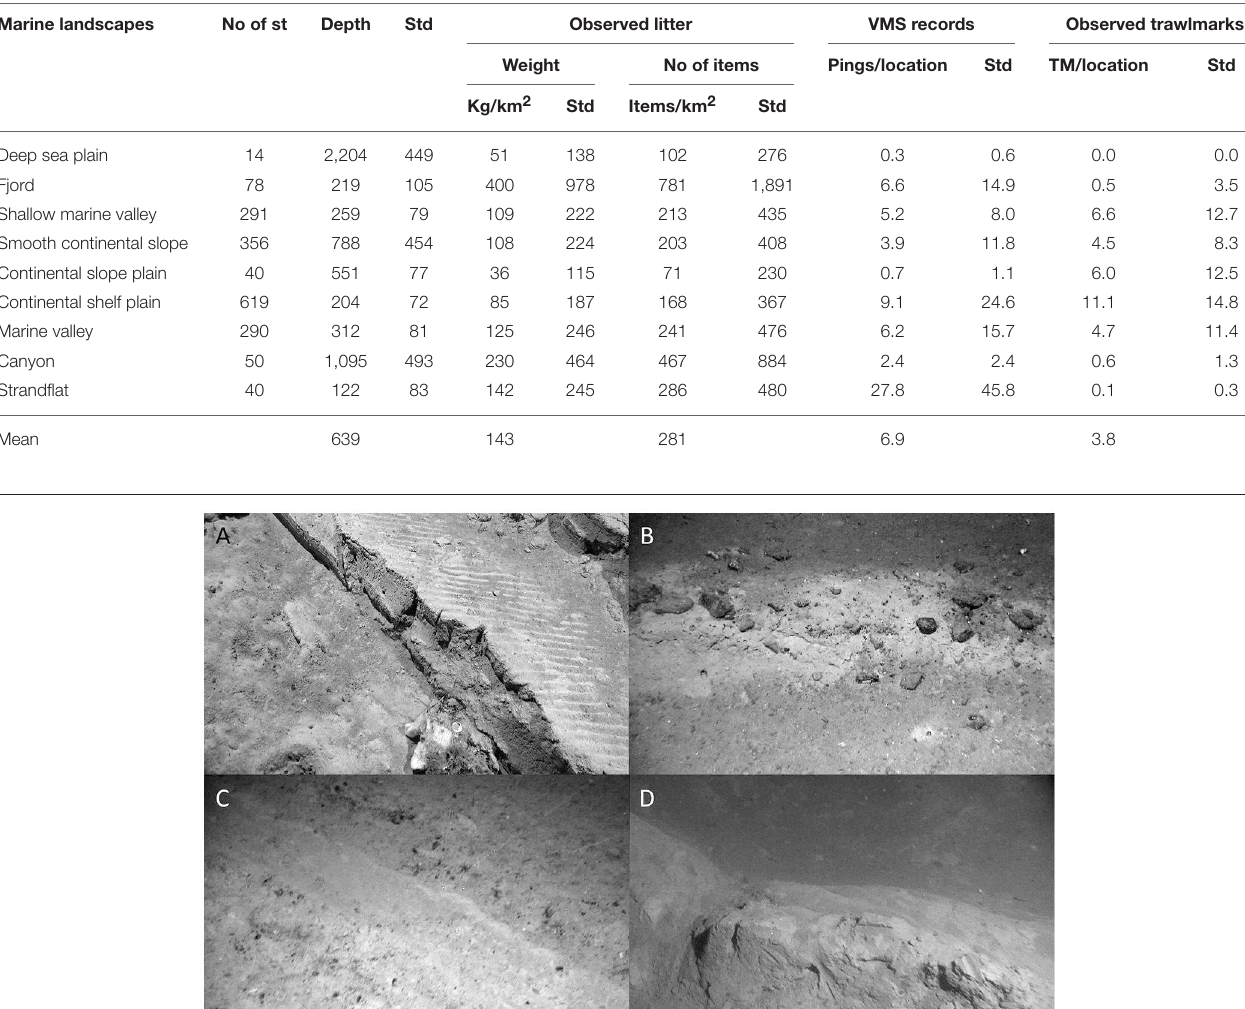
TABLE 1 | Overview of density of litter and trawlmarks (TM) observed during MAREANO cruises and VMS data from the Norwegian Fisheries directorate (from 2003 to 2015). Marine landscapes